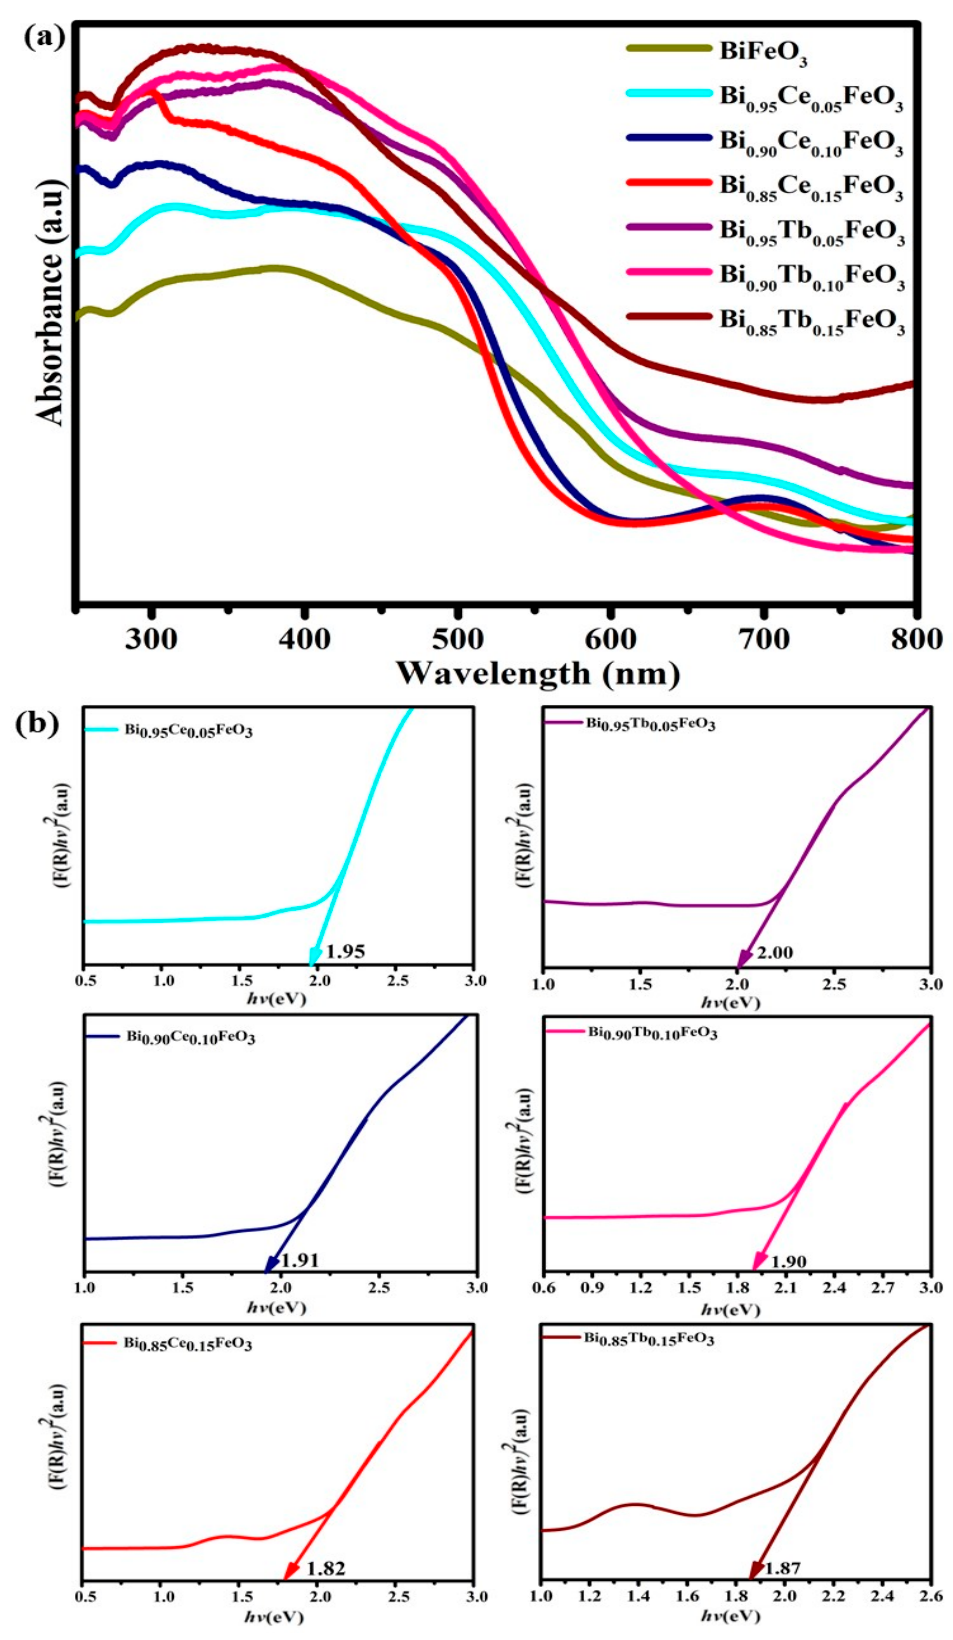
Figure 4. ( a ) DRS spectra of BFO: RE nanostructures. ( b ) ( F (R) hv ) 2 versus photon energy ( hv ) for the Bi 1 − x R x FeO 3 (R = Ce, Tb; x = 0.05, 0.10 and 0.15) nanostructures. The possible reduction in the bandgap could be ascribed to the RE-substitution in- duced formation of new energy states (defect levels) introduced between the valence band and conduction band [46]. Another perspective is the structural distortion persuaded modification in RE-modified BFO nanostructures. The bond angle variation in Fe-O-Fe due to the RE substitution also results in the reduced band-gap energy. The hybridization